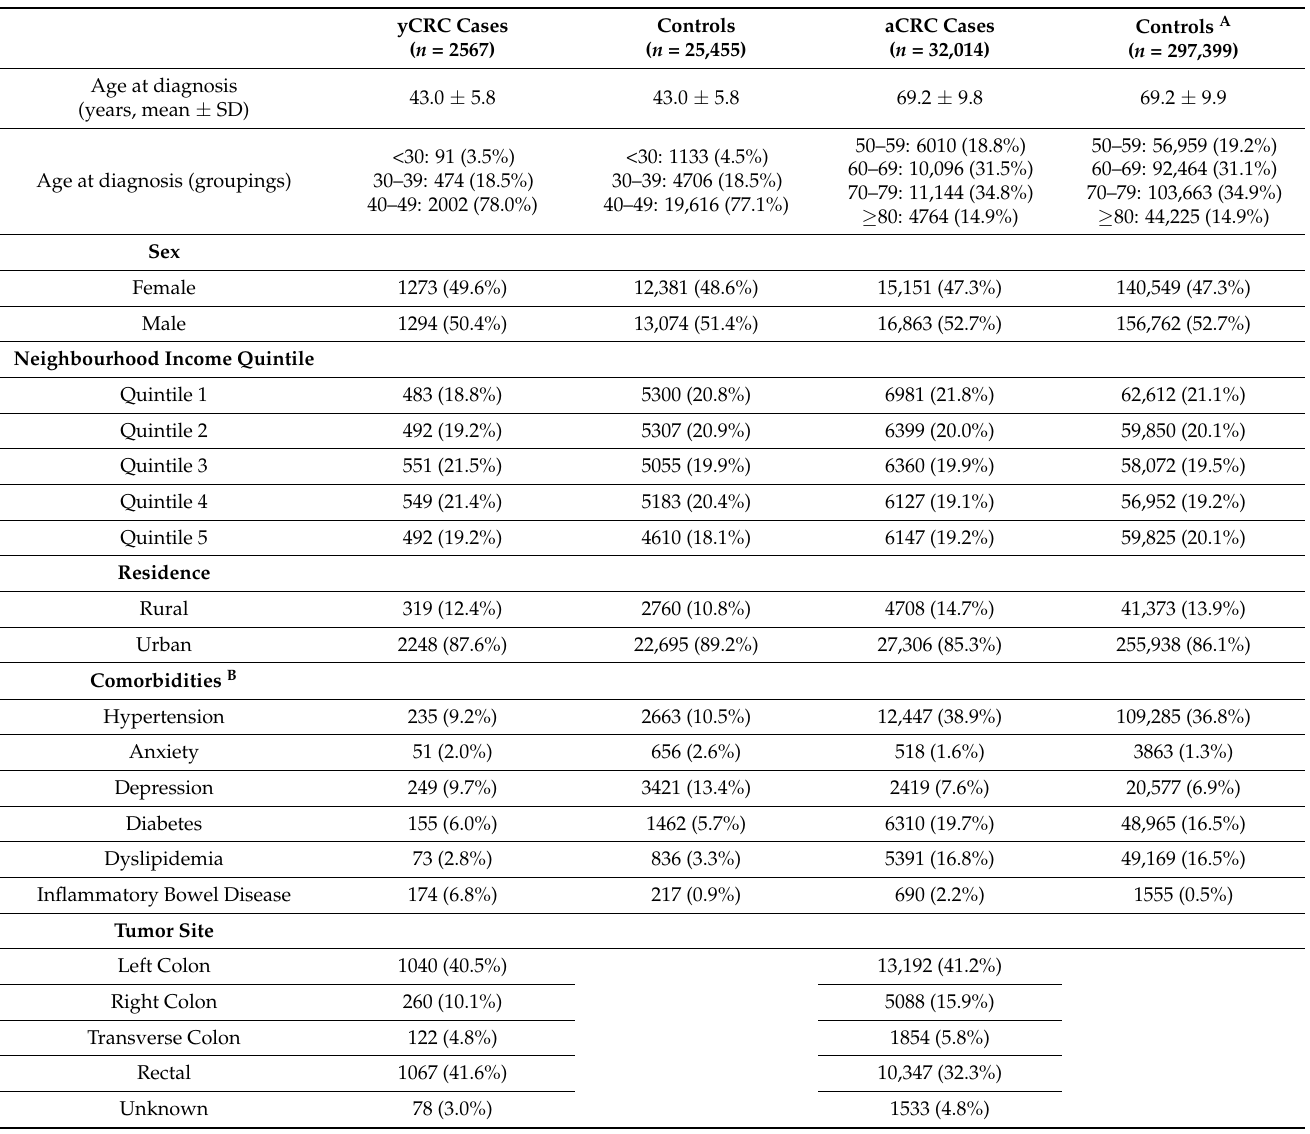
Table 1. Characteristics of individuals with young-onset colorectal cancer (yCRC; <50 years), average- onset colorectal cancer (aCRC; ≥ 50 years) and respective cancer-free